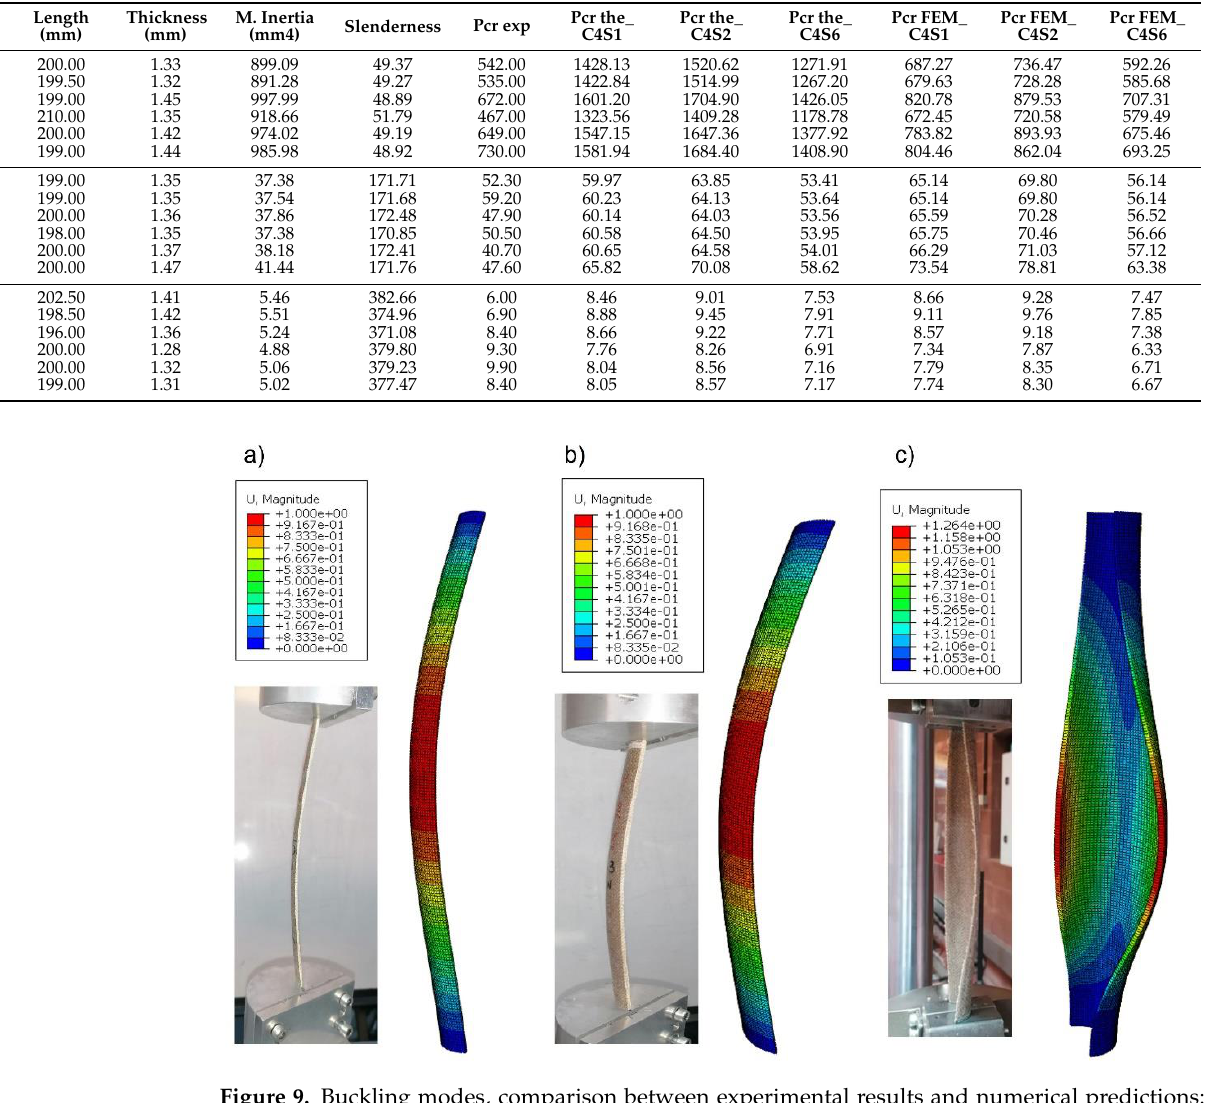
Figure 9. Buckling modes, comparison between experimental results and numerical predictions: ( a ) C60 section, ( b ) C90 section, ( c ) C180 section.